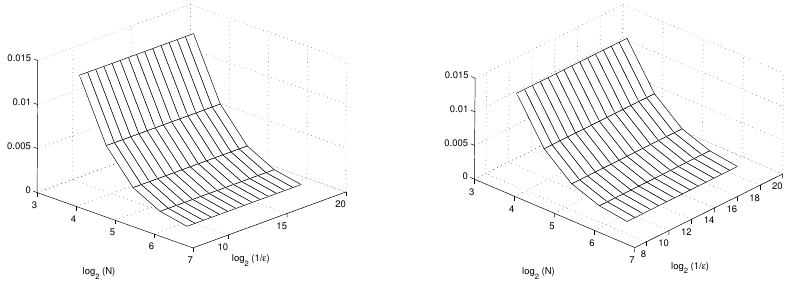
Figure 4. Surface plot of the maximum pointwise errors as a function of N and ε for the scaled discrete derivative components εD 0 Y 1 and εD 0 Y 2 using HDS - II for the Example 1.